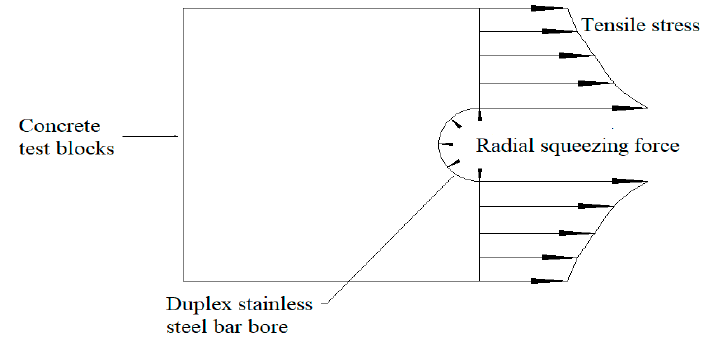
Figure 9. Concrete test block force